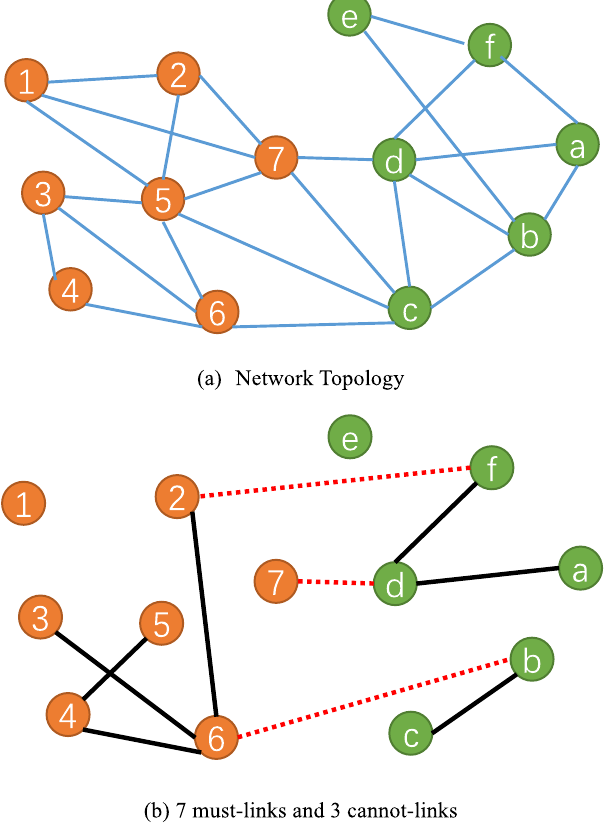
Figure 1. The network topology ( a ) and pairwise (must-link and cannot-link) constraints ( b ). In ( b ) the black solid line and the red dashed line denote the must-link and cannot-link constraints,